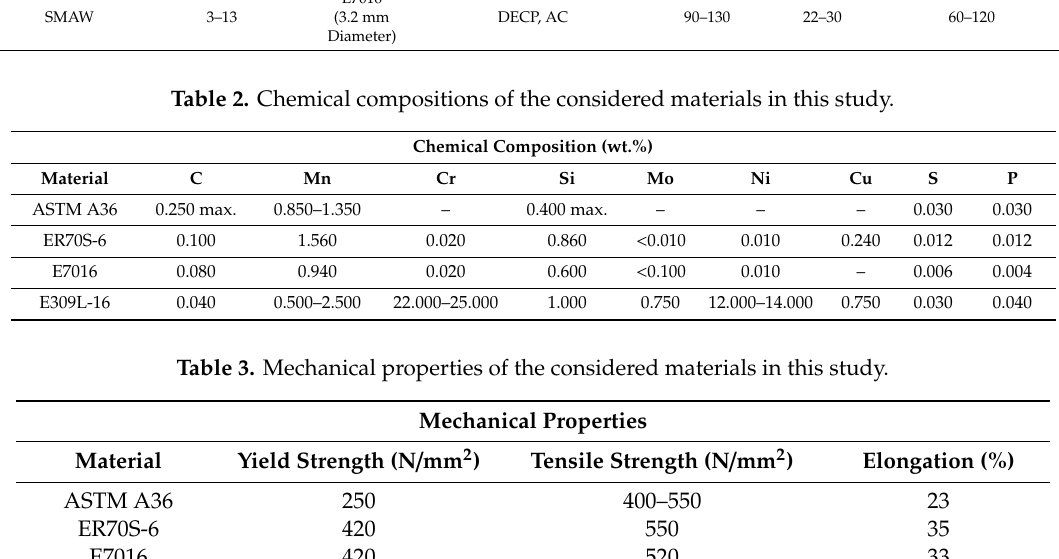
Figure 3. The schematic of the cladding process: ( a ) Shielded metal arc welding (SMAW); ( b ) A36— A36 welded substrate; ( c ) Hard facing overlay; ( d ) Grinding; ( e ) Cladding surface. SMAW was carried out to create a hard-facing overlay of 2.8–3.0 mm. Note that the cladding direction was perpendicular to the weld direction or A36—A36 weldment. The detailed information about the SMAW process is described in Table 4. After the entire surface was coated with 309L stainless steel, the top surface (overlay) was ground to have approximately 2.8 mm thickness. Table 4. Cladding process condition. Welding Process